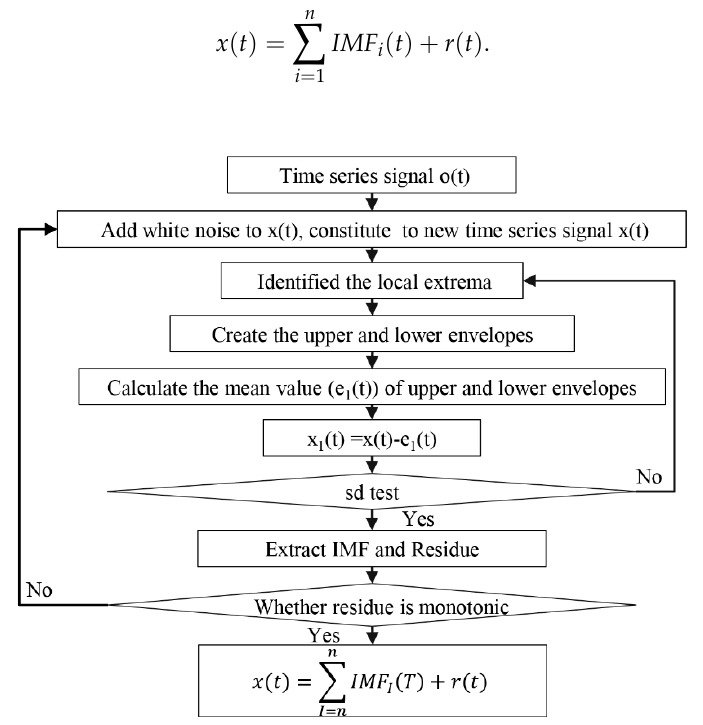
Figure 4. A flow chart of the ensemble empirical mode decomposition (EEMD) method.